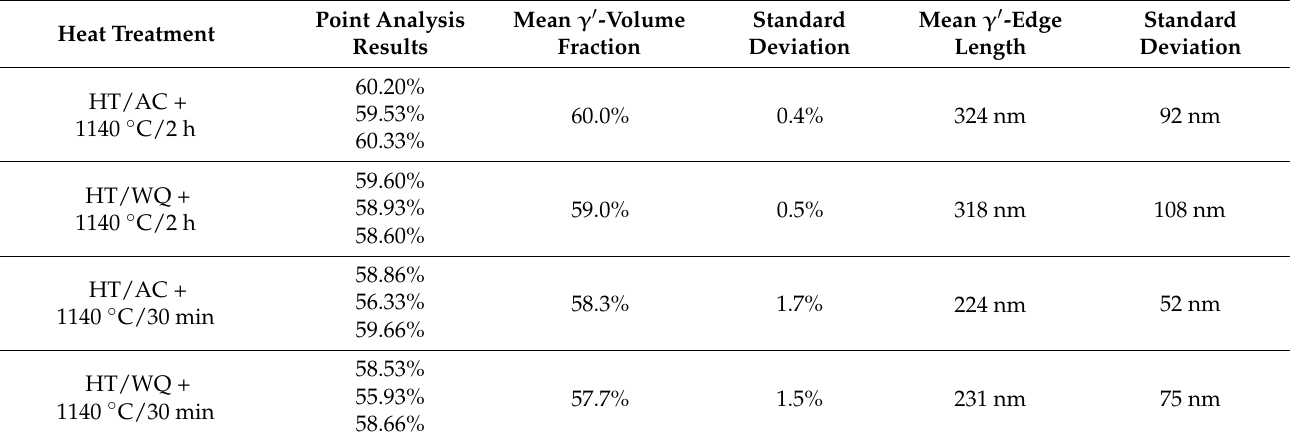
Table 3. γ (cid:48) -edge length and γ (cid:48) -volume fraction of the AC and WQ samples with additional heat treatment at 1140 ◦ C and a reduced precipitation